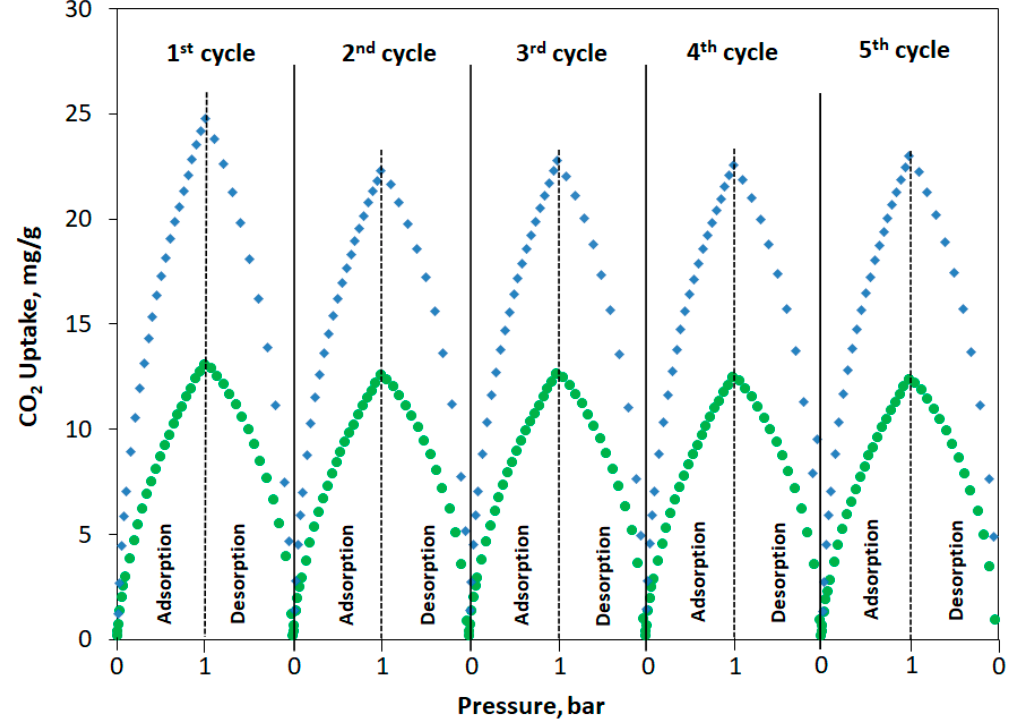
Figure 3. Five correlative CO 2 adsorption/desorption isotherms (from 0.006 to 1 bar) at 0 °C for PUR2.BF 4 (blue squares) and PU1.BF 4 (green circles) carried out without degasification step between cycles.